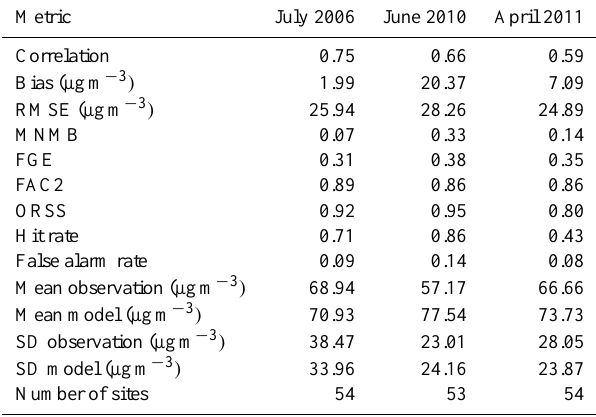
Table 4. Model performance metrics for ozone for the three case study periods, July 2006, June 2010 and April 2011. An ozone threshold of 100µgm − 3 was used in the calculation of the ORSS, hit rate and false alarm rate metrics. The mean and standard devia- tion (SD) of observations and model values are also shown.